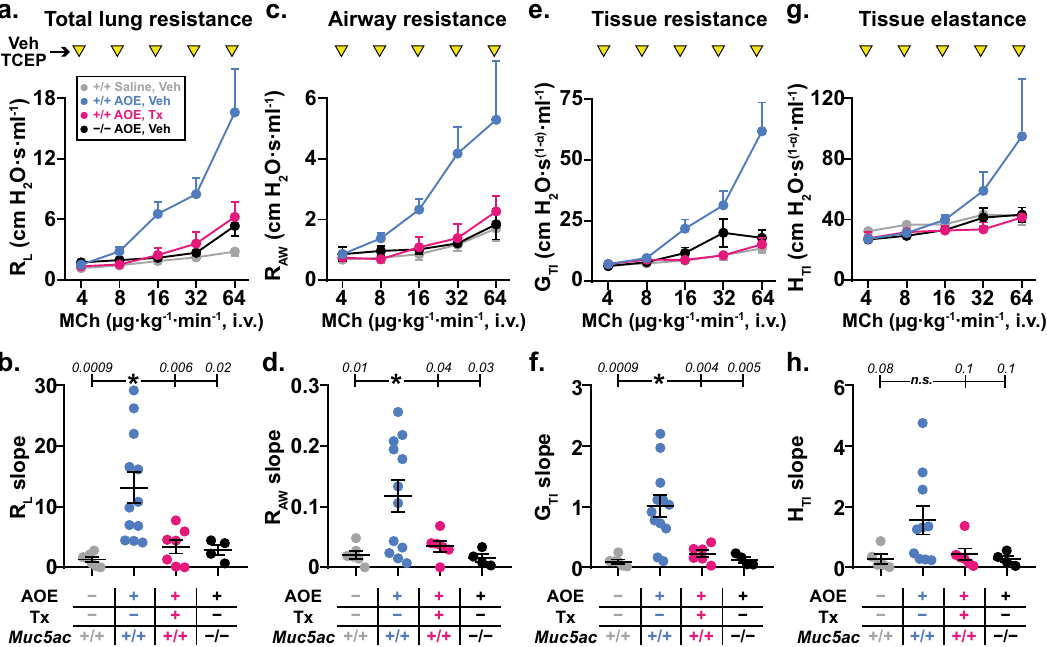
Fig. 3 Mucolytic treatment reverses allergic airway hyperreactivity. Dose response curves to methacholine (MCh, 4 – 64 μ g kg − 1 min − 1 , i.v.) were generated in AOE challenged allergic wild type (WT) mice (magenta, n = 7 biological replicates) treated with TCEP between MCh doses (100 mM, inverted yellow triangles). For comparison, saline challenged non-allergic WT mice (gray, n = 6 biological replicates), AOE challenged allergic WT mice (cyan, n = 12 biological replicates), and AOE challenged Muc5ac − / − mice (black, n = 4 biological replicates) were treated with nebulized vehicle (Veh) during i.v. MCh dose response tests. Values are means ± sem. For each mouse, dose response curves were fi tted by log-linear best- fi t regression analysis, and slopes of regression lines were analyzed by one-way ANOVA. “ * ” , p < 0.05 using Dunnett ’ s test for multiple comparisons relative to AOE-challenged Veh-treated WT mice ( p -values are shown). Total lung resistance ( R L in a , b ), conducting airway resistance ( R AW in c , d ), tissue resistance ( G TI in e , f ) and tissue elastance ( H TI in g , h ) are shown. Source data are provided as a Source Data fi